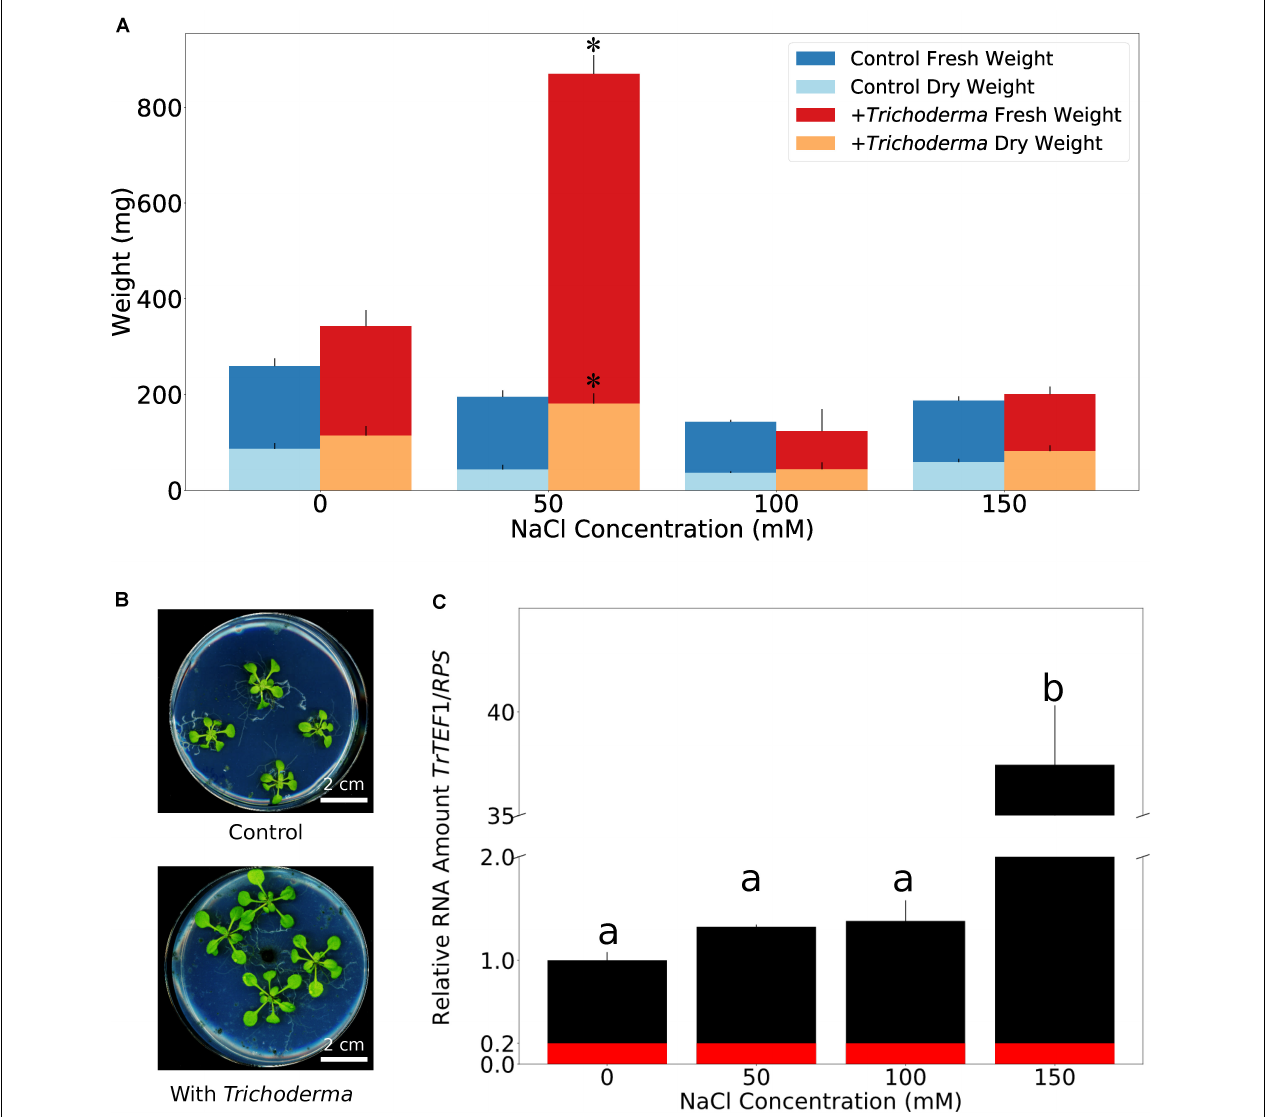
FIGURE 5 | Mild salt condition optimizes fungal colonization and plant growth performance on synthetic medium. (A) Fresh and dry weights of A. thaliana co-cultivated with or without Trichoderma on PNM medium with 0–150 mM NaCl for 5 days. Error bars represent SEs from three independent biological replicates, each with four seedlings. Statistical significance was determined by 2-Way ANOVA. Post-hoc analysis between all groups was further carried out by Tukey HSD test with P < 0.05, and is shown in Supplementary Table 3 . Asterisks indicate significant difference in fresh/dry weight of seedlings grown on 50 mM NaCl with or without Trichoderma . (B) Growth phenotype of A. thaliana on PNM medium with 50 mM NaCl 5 days after co-cultivation with or without Trichoderma . (C) Quantification of Trichoderma root colonization on A. thaliana on PNM medium with 0–150 mM NaCl by qPCR. TrTEF1 : Trichoderma TEF1 ; RPS : A. thaliana ribosomal protein S13/S18 family. Error bars represent SEs from three independent biological replicates, each with four seedlings. Statistical significance was determined by Tukey’s HSD test with P < 0.05, and is indicated by different lower-case letters. Red color represents average background value referred from samples without Trichoderma